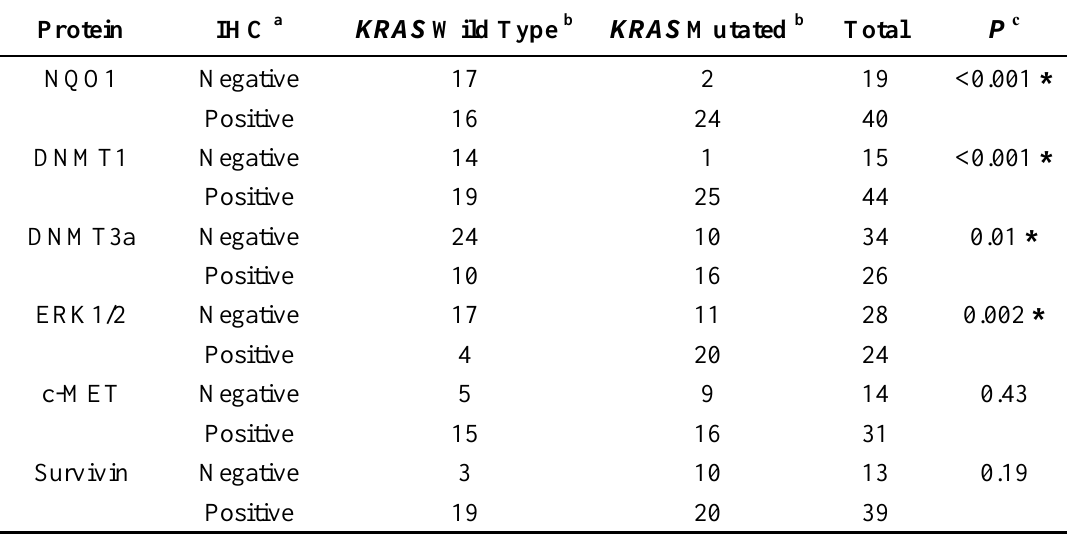
Table 1. Expression of NQO1 and clinically relevant proteins in non-small cell lung carcinoma patients with and without KRAS